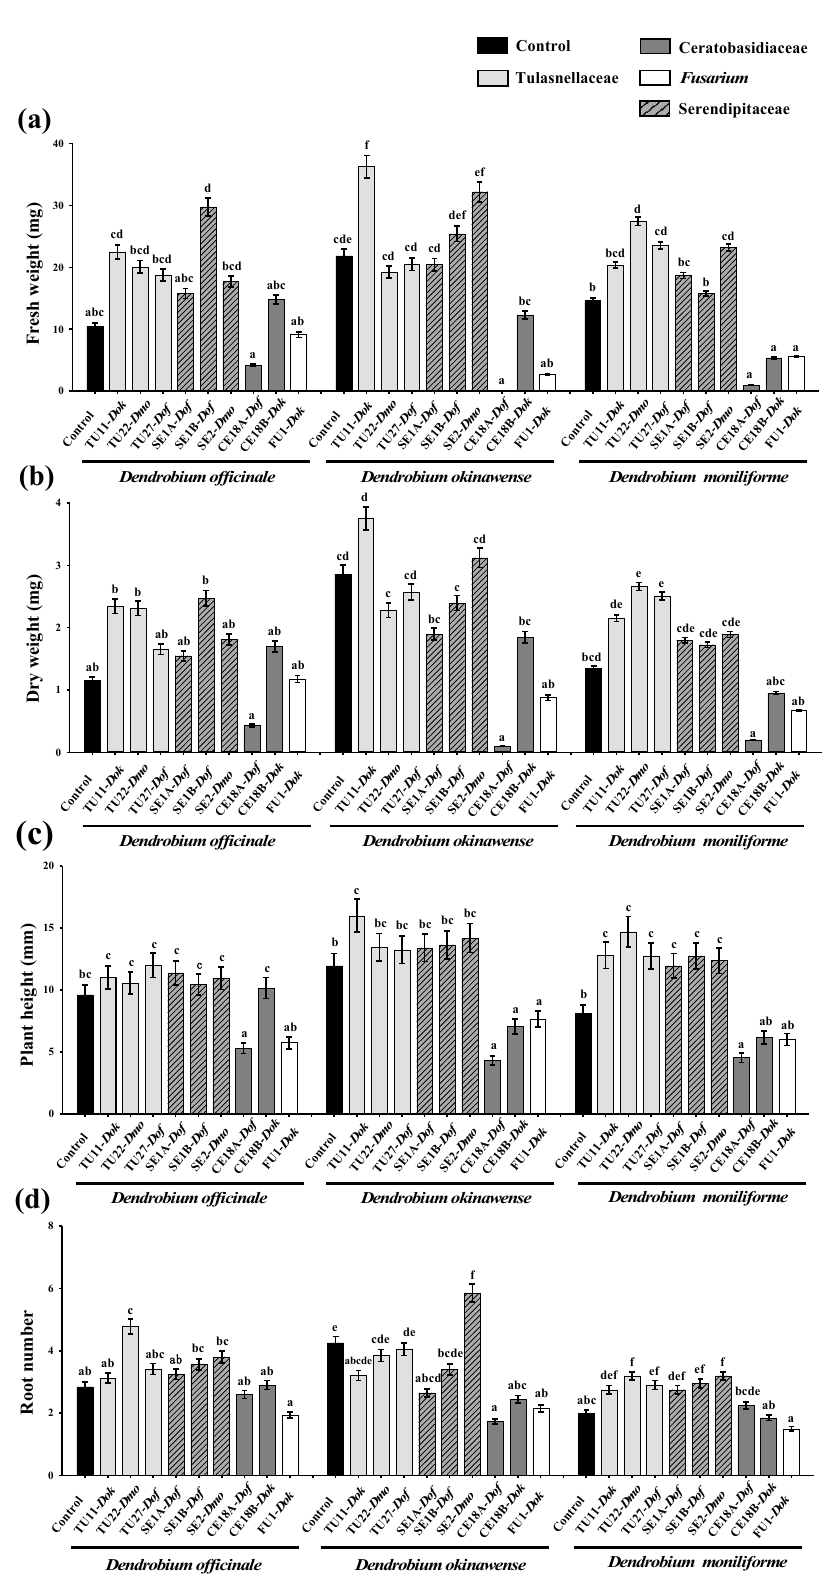
Figure 3. Effect of fungal isolates on the growth of asymbiotic cultured seedlings of Dendrobium officinale ( Dof ), D. okinawense ( Dok ), and D. moniliforme ( Dmo ) at three months after symbiotic culture. Fresh weight ( a ) and dry weight ( b ), plant height ( c ), and number of roots ( d ). Host orchid is indicated after the fungal isolate name. Bars show standard errors ( n = 20 plants per treatment). Mean values with different letters are significantly different at p < 0.05 (Tukey-Kramer test).